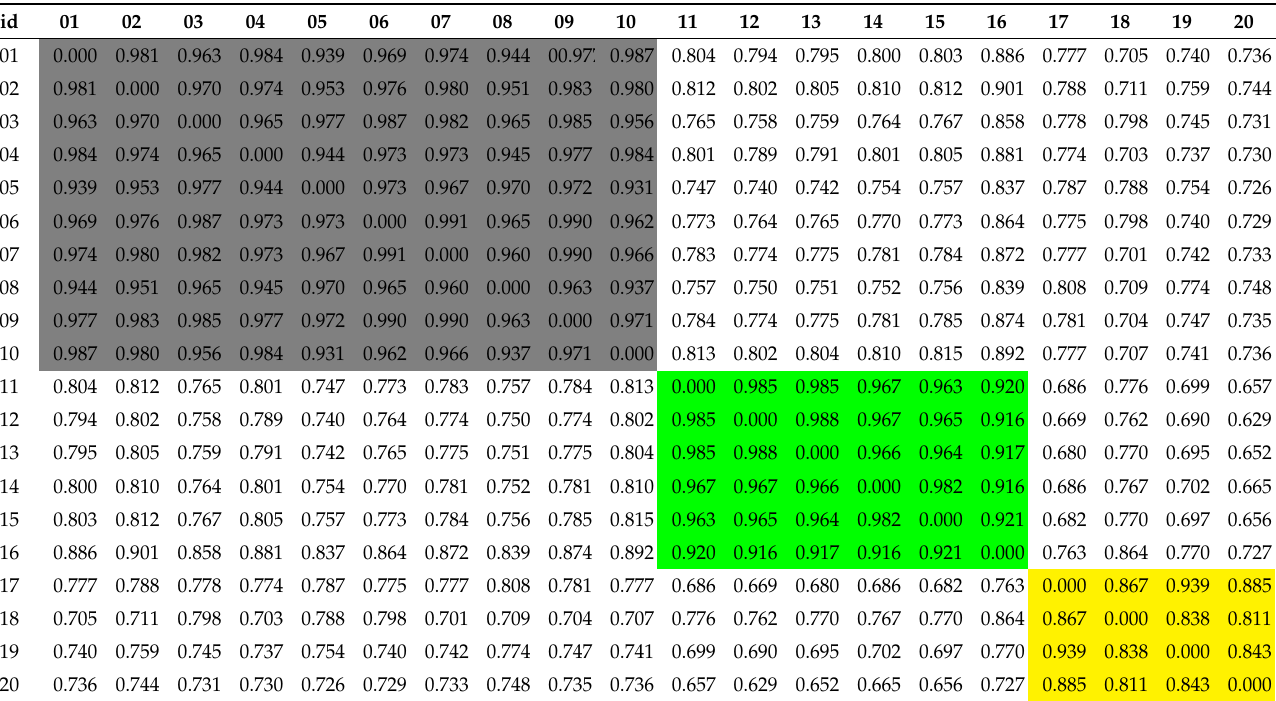
Table 3. The affinity matrix W A .